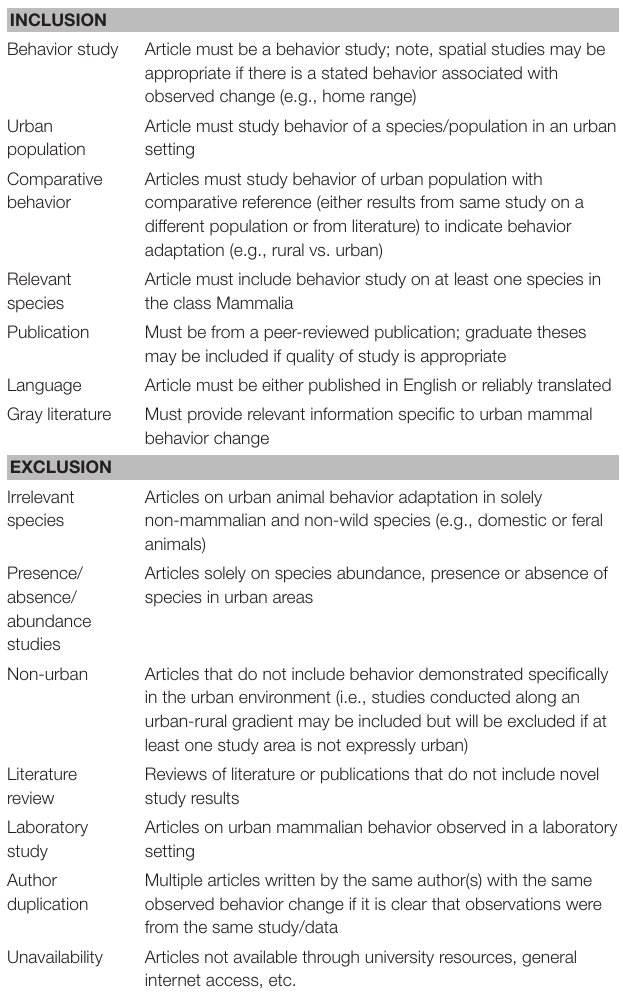
TABLE 1 | Criteria used to determine inclusion/exclusion of articles for literature